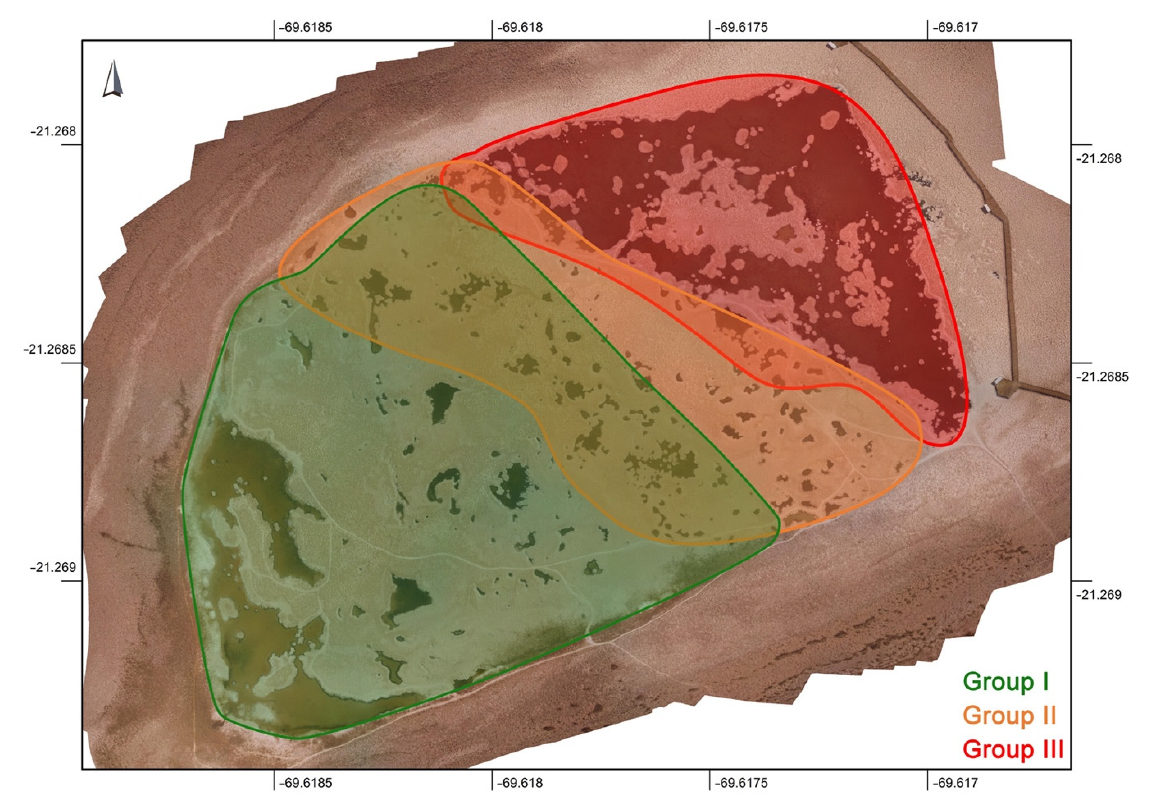
Figure 8. Map of the Puquio 1 and Puquio 2 system showing the generalized geographic region of Group I (carpet, black domes, black semi-cohesive mat, floccules, network, and orange–brown bulb- ous mat), Group II (orange gel mat and orange gel mat with black pinnacles) and Group III